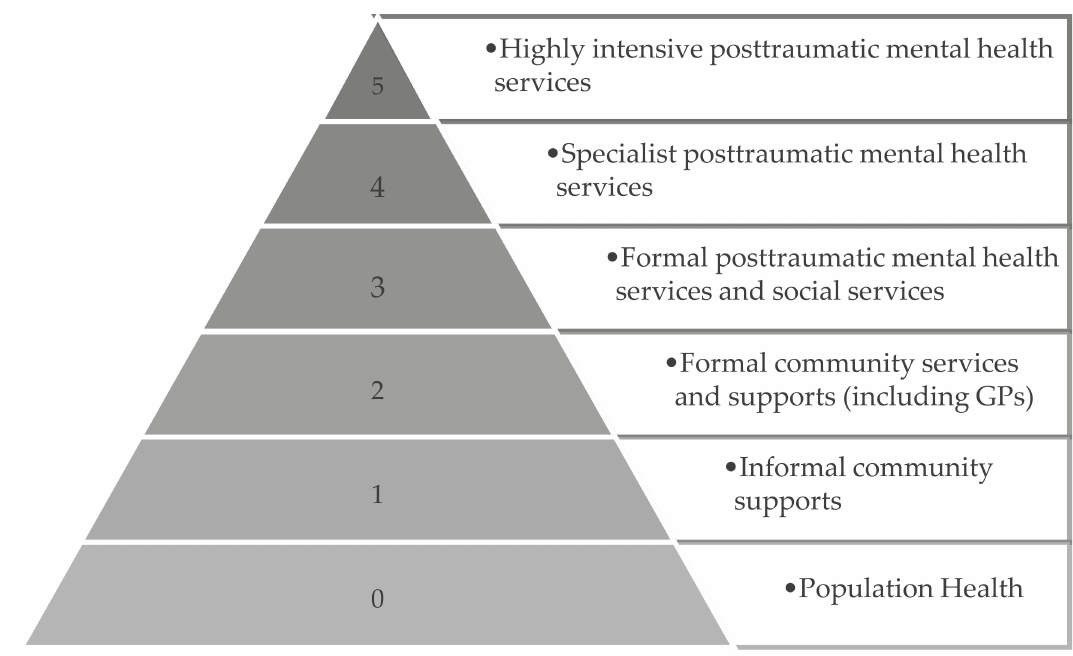
Figure 1. Overview of